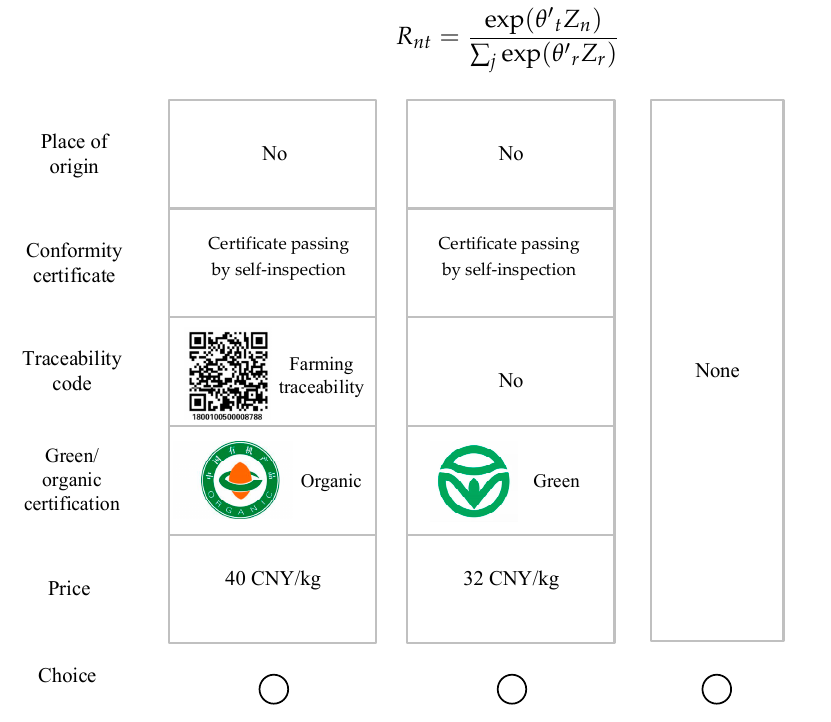
Figure 1. Sample choice set in a task.